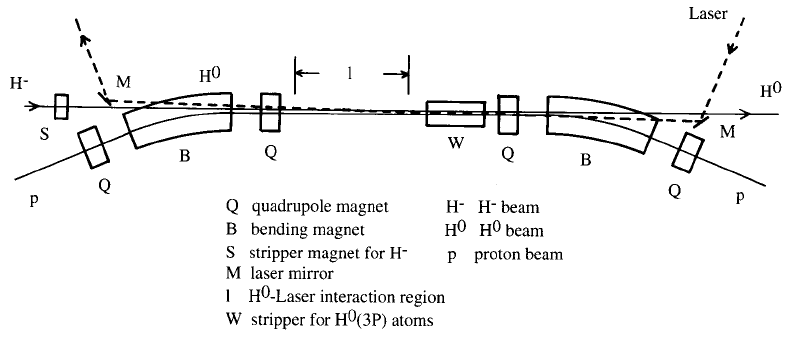
FIG. 8. New scheme of H 2 charge-exchange injection using Lorentz stripping and laser excitation of an H (cid:48) atom instead of a stripping